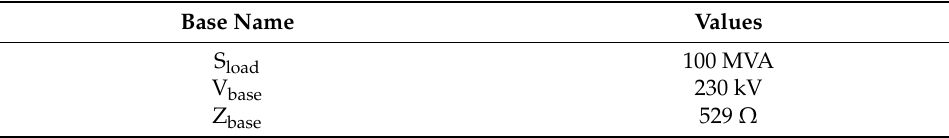
Table 4. Base values used in power systems.